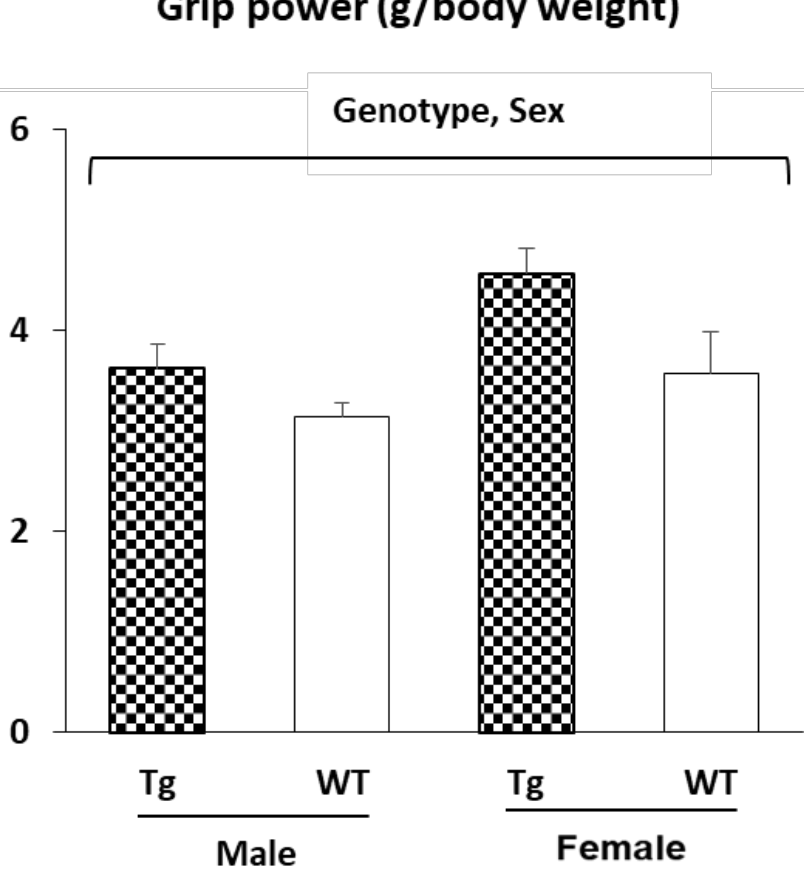
Figure 4. Muscle strength (grip power test): Sparc overexpression increased the grip power. Female mice had a higher grip power per body weight than male mice. All data are mean ± SEM. The number of mice: 5–11 mice per experimental condition. Abbreviations: g, gram; Sparc , secreted protein acidic and rich in cysteine; Tg, transgenic ( Sparc overexpression); WT, wild-type.